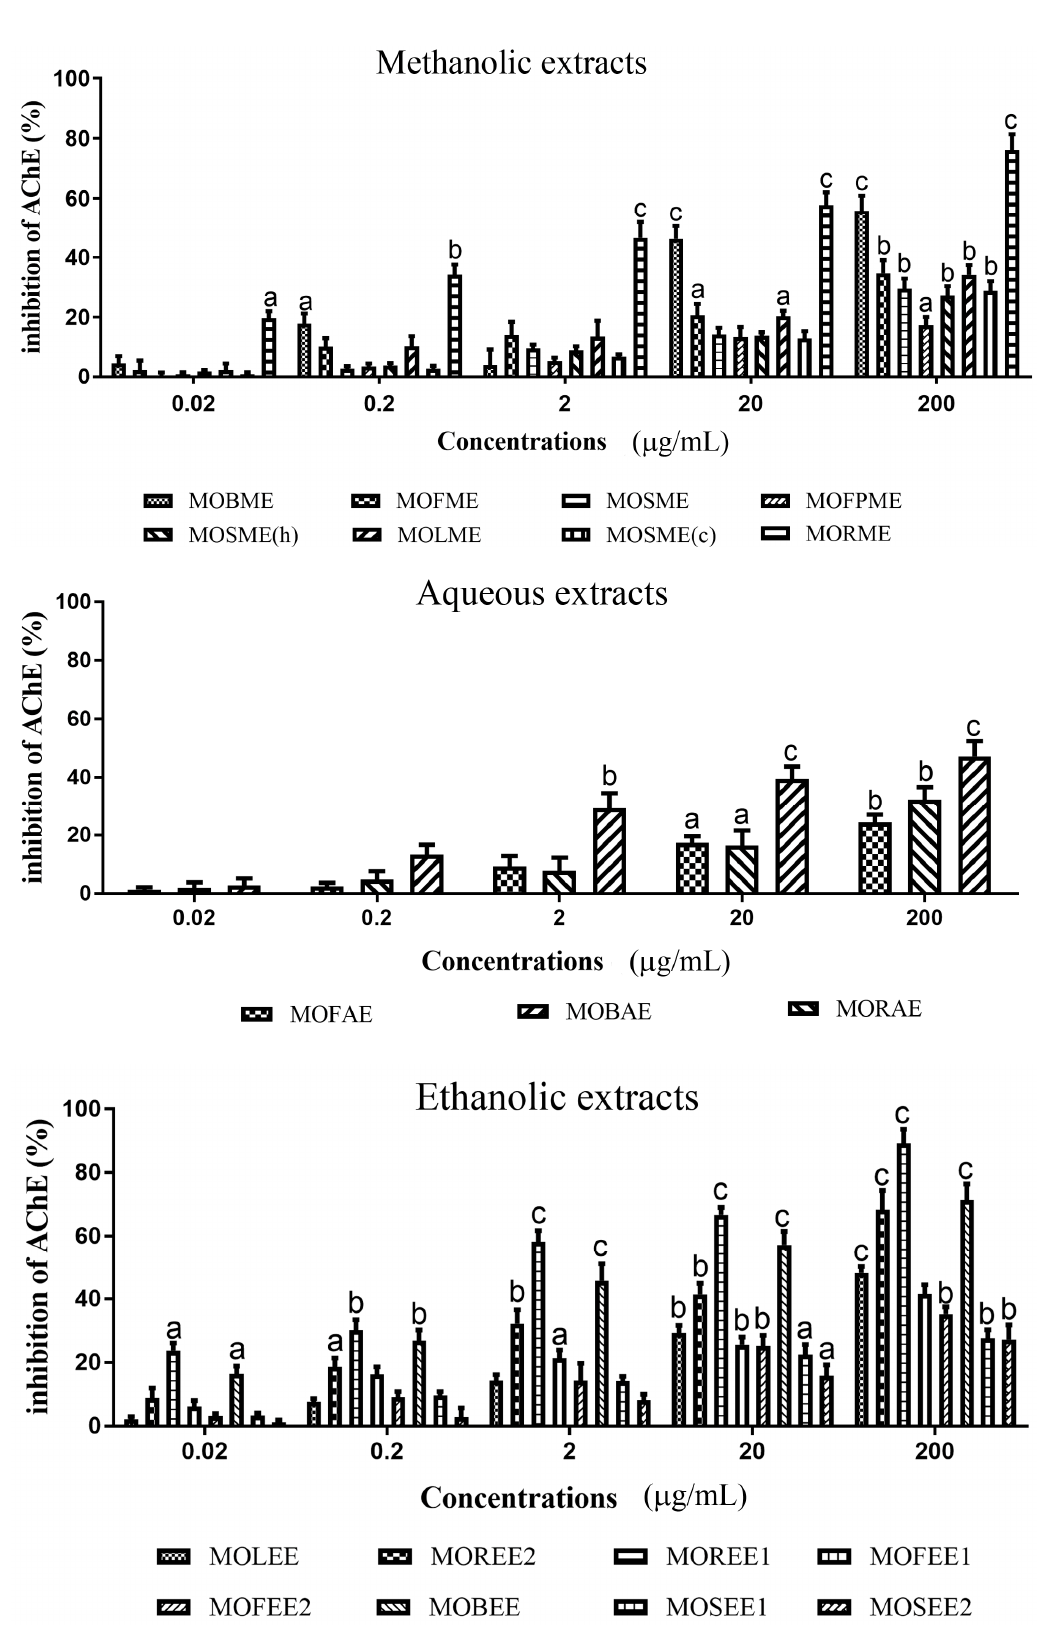
Figure 1. Acetylcholinesterase (AChE) inhibitory activity of plant extracts from Moringa oleifera . Plant extract inhibition of AChE was measured using a modified Ellman assay, with percentage inhibition of AChE calculated relative to eserine. The histograms presented are means ± SEM for at least three replicate assays at each extract concentration. a; p < 0.05. b; p < 0.01. c; p < 0.001.